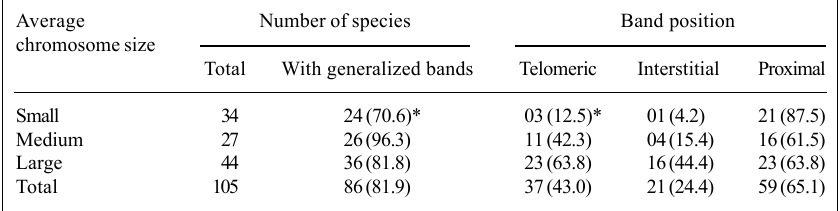
Table III - Number and percentage of species with generalized equilocal bands in different chromosomal positions for chromosomes of different sizes (based on Table I).